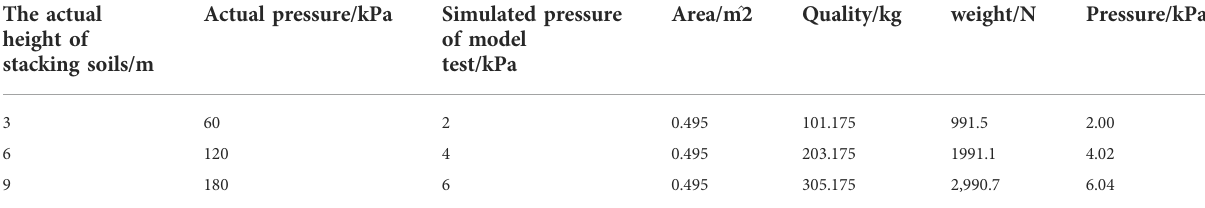
TABLE 1 Conversion of loading values in modeling tests.